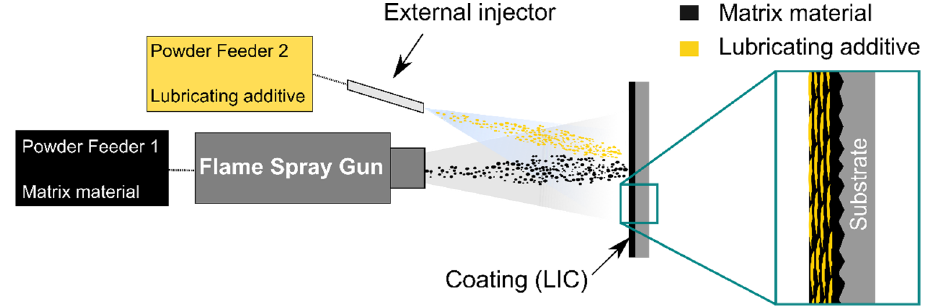
Figure 1. Schematisation of the flame spray process with hybrid feedstock injection to produce lubricated icephobic coatings (LICs).